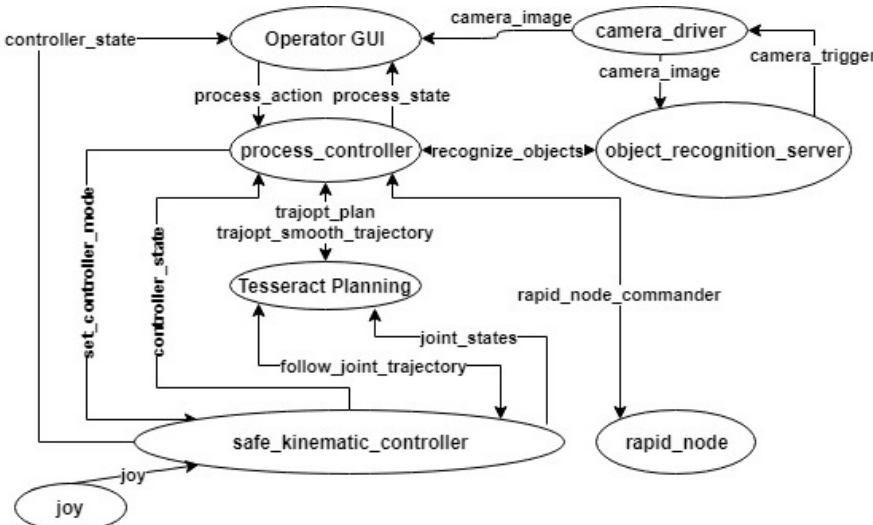
Figure 5. The ROS software architecture implements the entire process, including user interface, motion planning (using Tesseract), vision service and object recognition, robot kinematic control, and robot